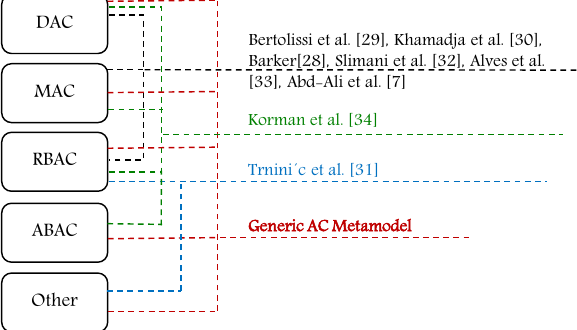
Figure 7. AC features in the core structure for each of the proposed